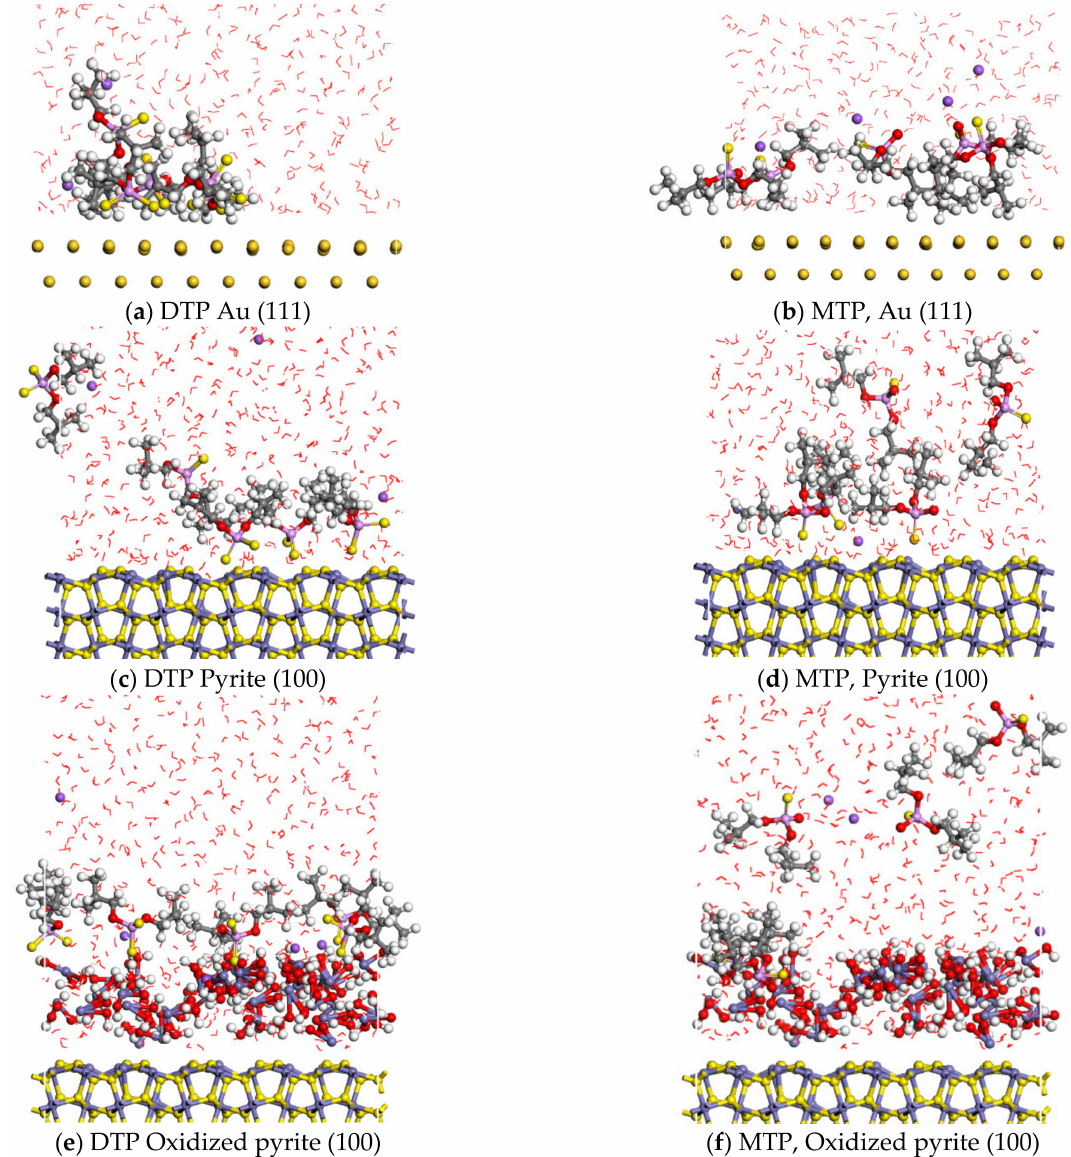
Figure 3. Interfacial behavior of DTP and MTP at the Au (111) surface ( a , b ), pyrite (100) surface ( c , d ), and oxidized pyrite (100) surface ( e , f ). Reagent: white: hydrogen; grey: carbon; red: oxygen; pink: phosphorus; yellow: sulfur. Fe(OH) 3 : dark grey: iron; white: hydrogen; red: oxygen. Pyrite: yellow: sulfur; purple: iron. Gold: dark yellow: